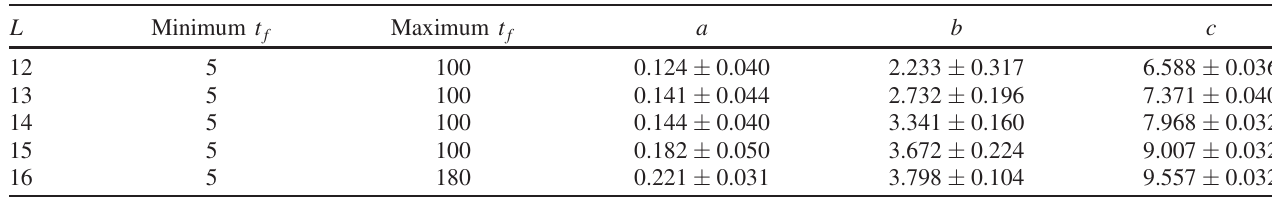
TABLE VIII. Fit to y ¼ a ð x − b Þ 2 þ c for the median results of the logical-planted instances using the DW2KQ with y ¼ log TTS and x ¼ log t . f